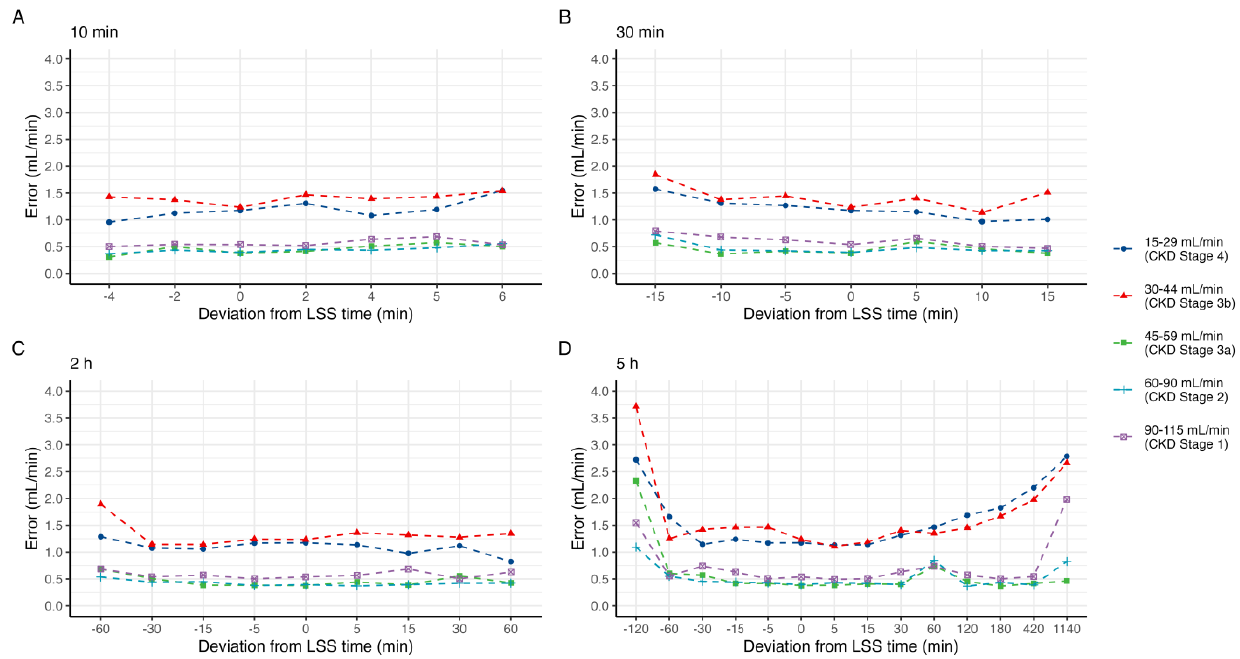
Figure 3. Median absolute error in predicted mGFR by deviation in sample time at point ( A ) 10 min, ( B ) 30 min, ( C ) 2 h, and ( D ) 5 h, grouped by CKD stage.